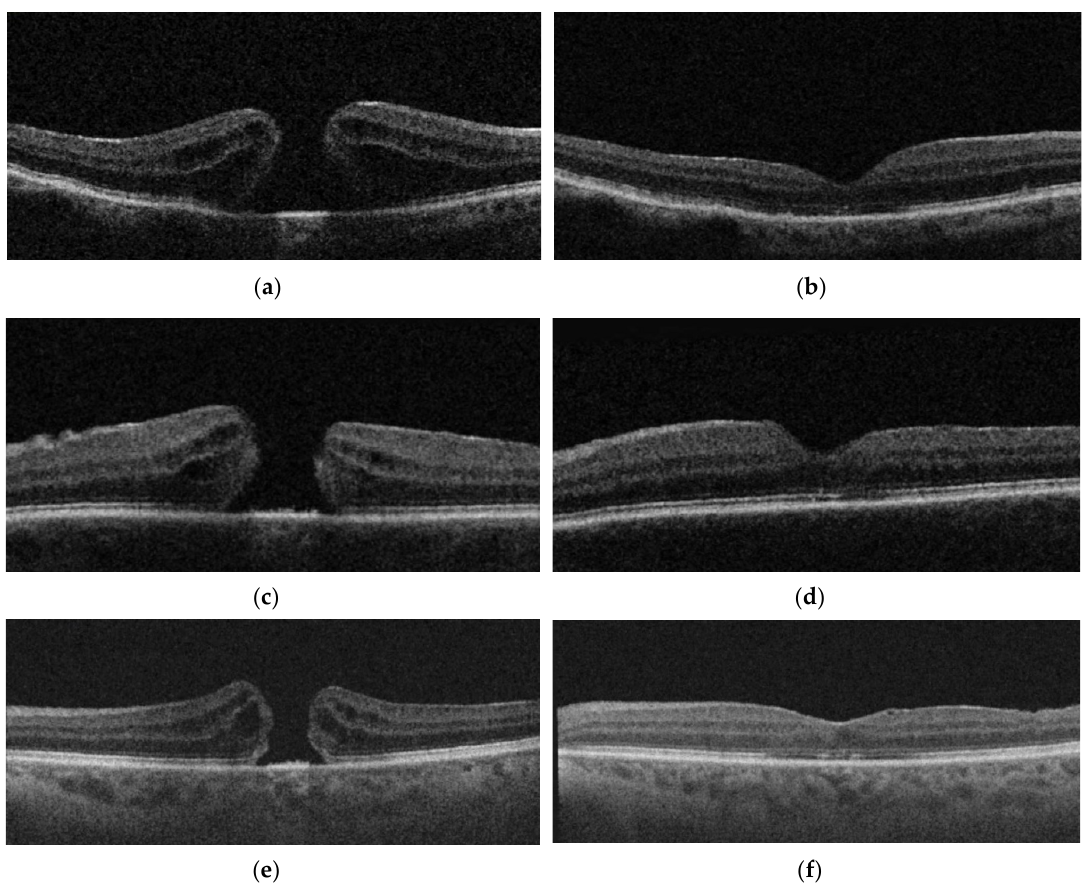
Figure 3. Representative OCT finding pre- and post-operatively for each of the three groups studied.